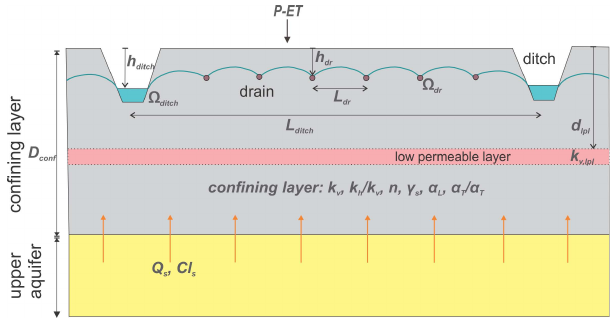
Fig. 5. Conceptual schematization of the cross-sectional 2-D-